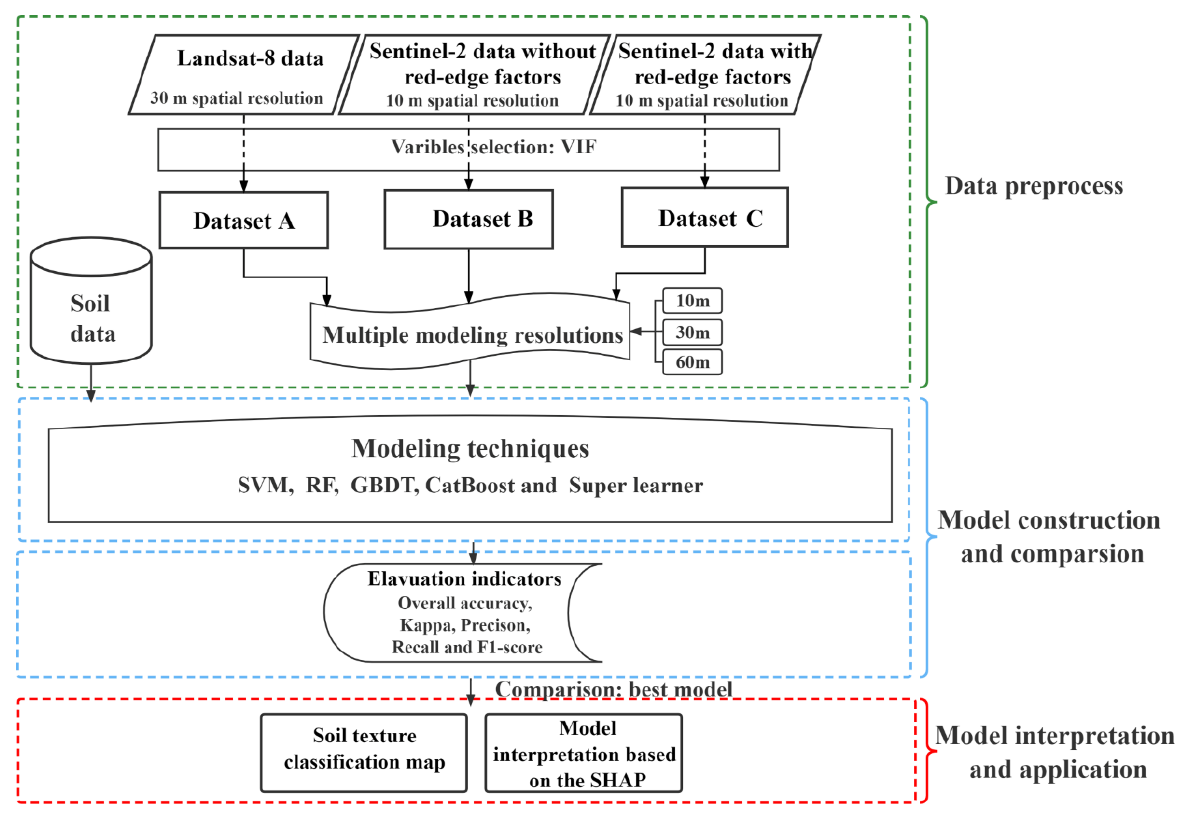
Figure 3. Flowchart for methodology.